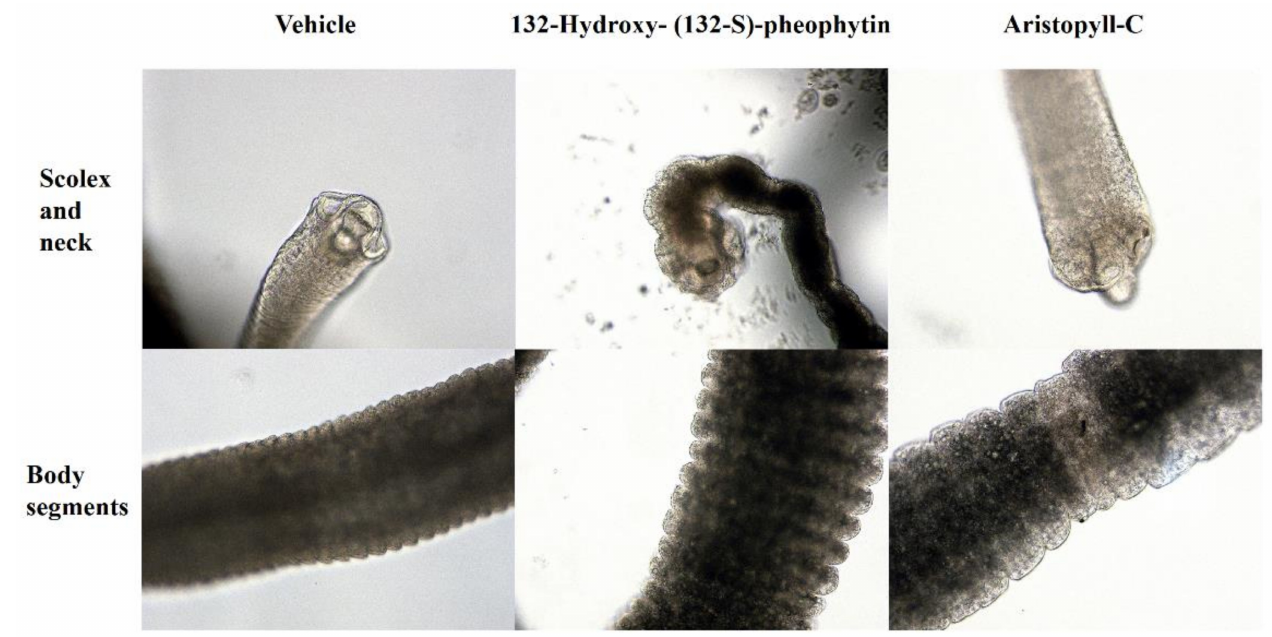
Figure 5. Morphology of H . nana segments at 6 h of drug treatment. H. nana was incubated with 0.1% DMSO as vehicle, 13 2 -hydroxy-(13 2 -S)-pheophytin a, and aristophyll-C at 100 µ M, and the images were collected at 200 ×